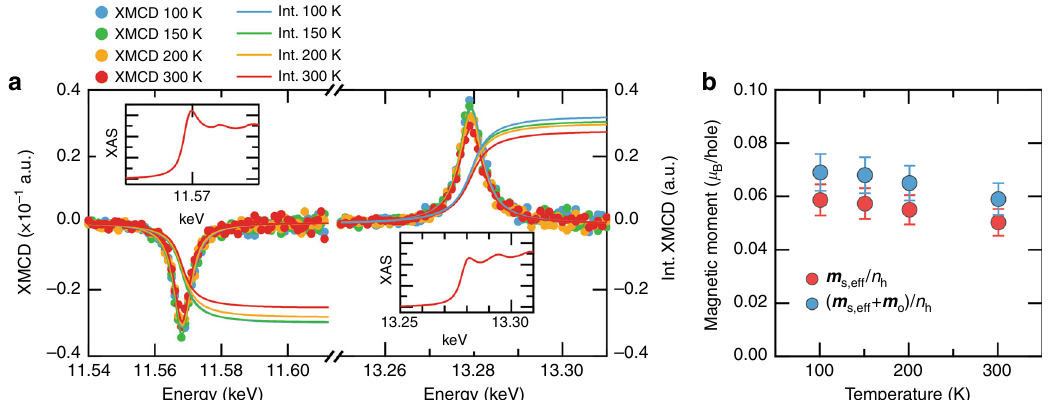
Fig. 3 Temperature dependence of the proximity-induced moment in the Pt layer. a The XMCD and integrated XMCD spectra at the Pt L 3 and L 2 edges in terms of temperature. The XMCD spectra were fi tted by the Lorentzian function, and the fi tted curves were integrated to get the integrated XMCD spectra. The insets are the XAS spectra at the Pt L 3 and L 2 edges. b Temperature dependence of the m eff standard deviation of the Lorentzian- fi